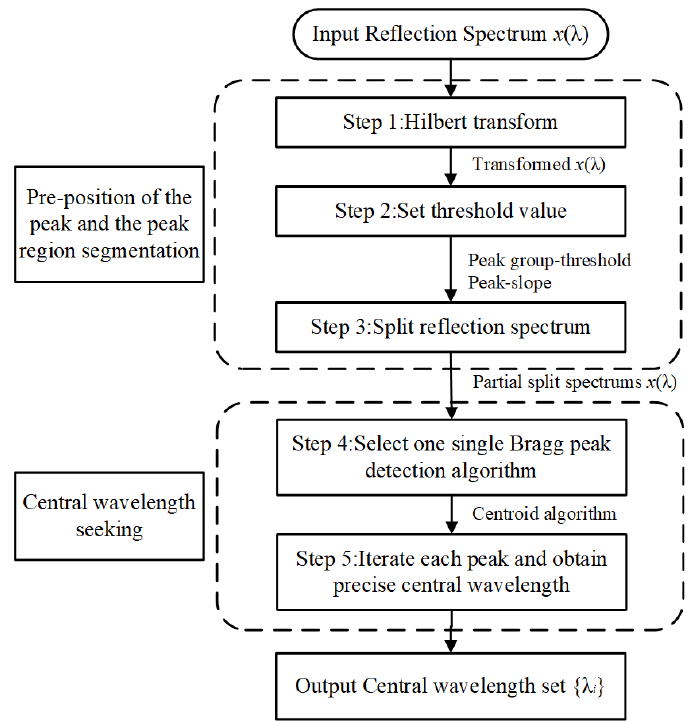
Figure 3. Algorithm flow of the multi-peak central wavelength detection algorithm.